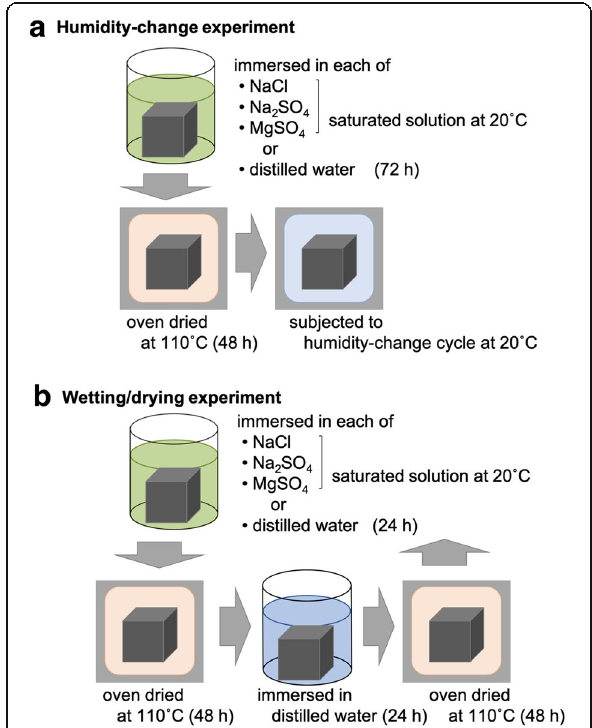
Fig. 1 Experimental design. a Humidity-change experiment. The weathering cycle was repeated 200 times. Weight, Equotip rebound value, and longitudinal wave velocity were measured every 20 cycles. b Wetting/drying experiment. The weathering cycle was repeated 20 times. Weight and Equotip rebound value were measured at the end of each weathering cycle